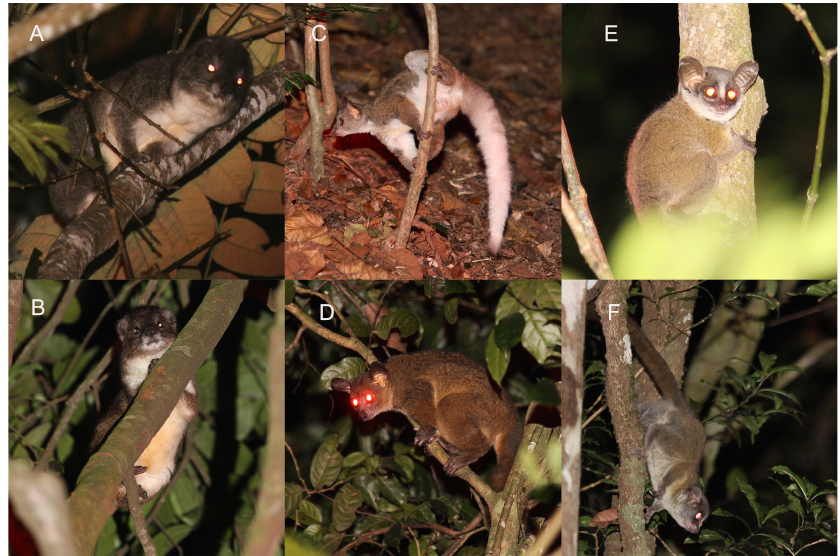
Figure 1. ( A ) Male Dendrohyrax with large and triangular tusk-like incisors. ( B ) Female Dendrohyrax with smaller and rounder incisors. ( C ) White tail-type Otolemur, young male. ( D ) Black tail-type Otolemur, sex unknown. ( E ) Paragalago, sex unknown. ( F ) Paragalago, sex unknown. All photographs taken by Hanna Rosti in Ngangao Forest, Taita Hills, in